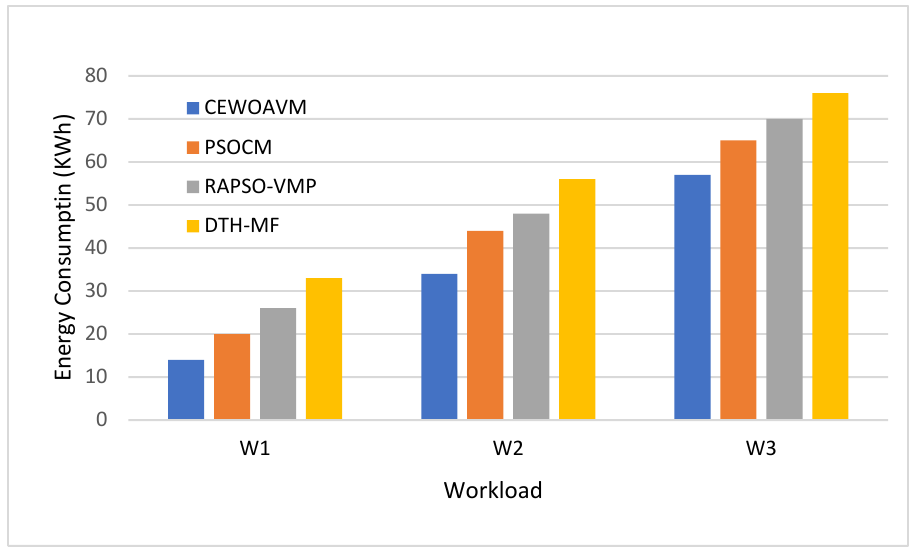
Figure 3. Comparison analysis of energy consumption.